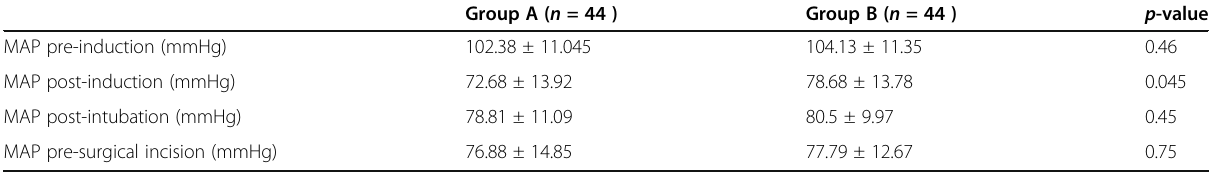
Table 2 Comparison of MAP values at basal and after anesthesia induction between the two study groups Group A ( n = 44